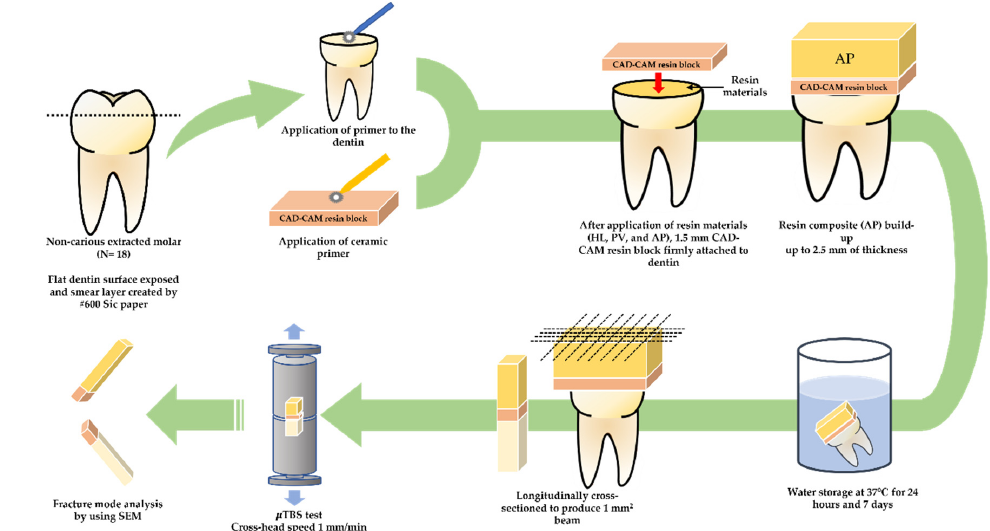
Figure 1. Graphical representation of specimen preparation and experimental set-ups for evaluating µTBS and fracture mode.